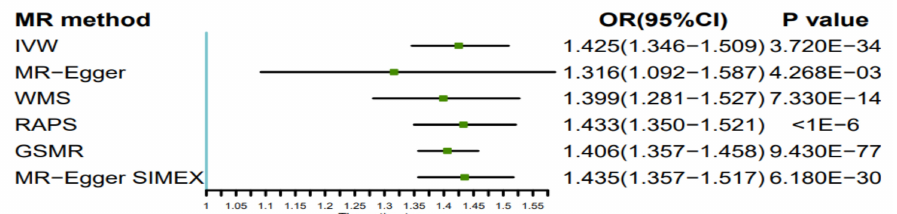
Figure 1. Forest plot of six Mendelian Randomization estimators of the effect of body mass index on atrial fibrillation. Abbreviations: MR, Mendelian randomization; OR, odds ratio; CI, confidence inter- val; WMS, weighted median estimator; RAPS, the robust adjusted profile score; GSMR, generalized summary data-based Mendelian randomization; SIMEX, simulation